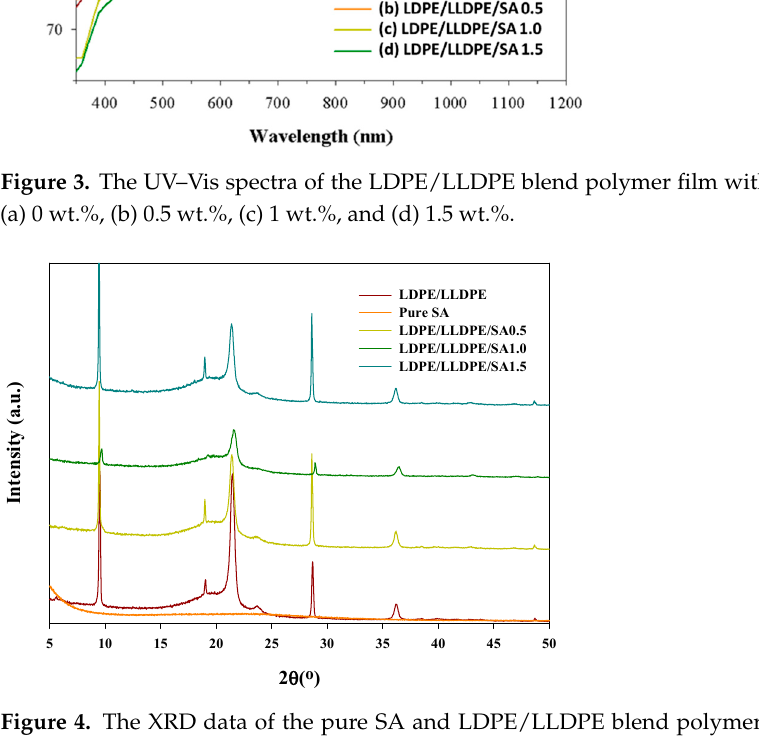
Figure 4. The XRD data of the pure SA and LDPE/LLDPE blend polymer film with various SA contents (0–1.5 wt.%).